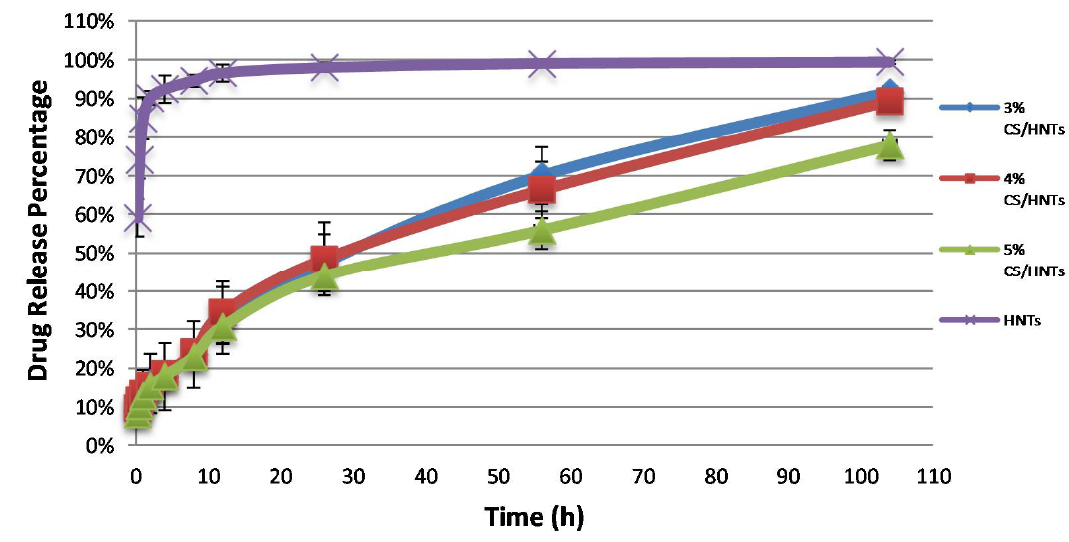
Figure 6. Accumulated drug release profiles for CS / HNTs hydrogels and pure drug-loaded HNTs. Every group contained the same amount of drug-loaded HNTs.